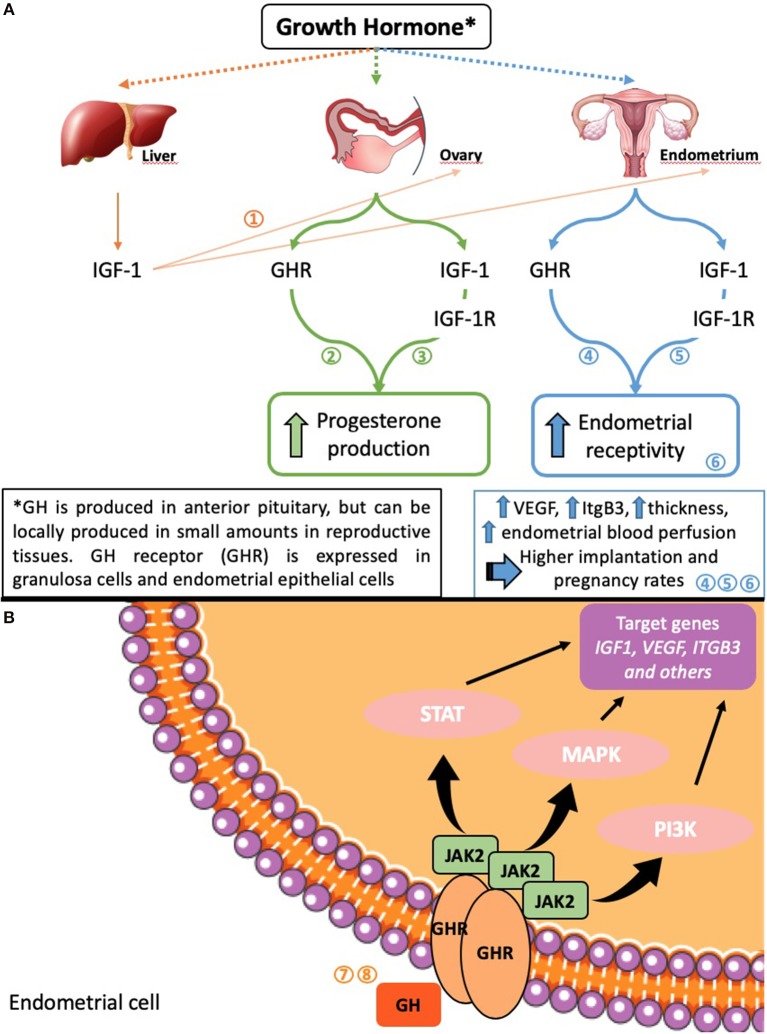
Possible mechanisms of GH effects on ovarian and endometrial function (A) and on endometrial cells (B). Numbers in the figure indicate studies where the information is presented in detail: 1 (39); 2 (40, 41); 3 (42); 4 (23); 5 (21); 6 (43); 7 (44); 8 (45).